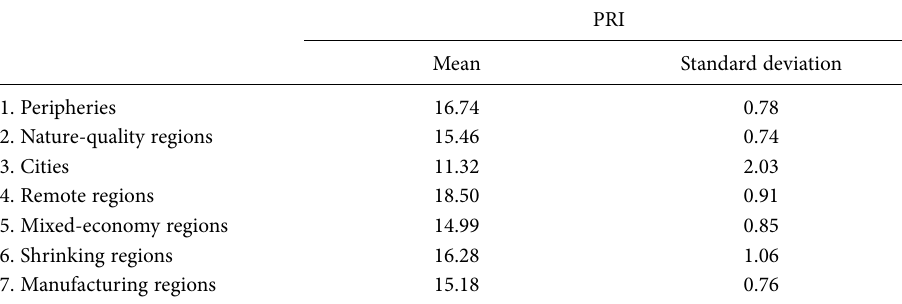
Table 4. PRI across clusters: averages and standard deviations.